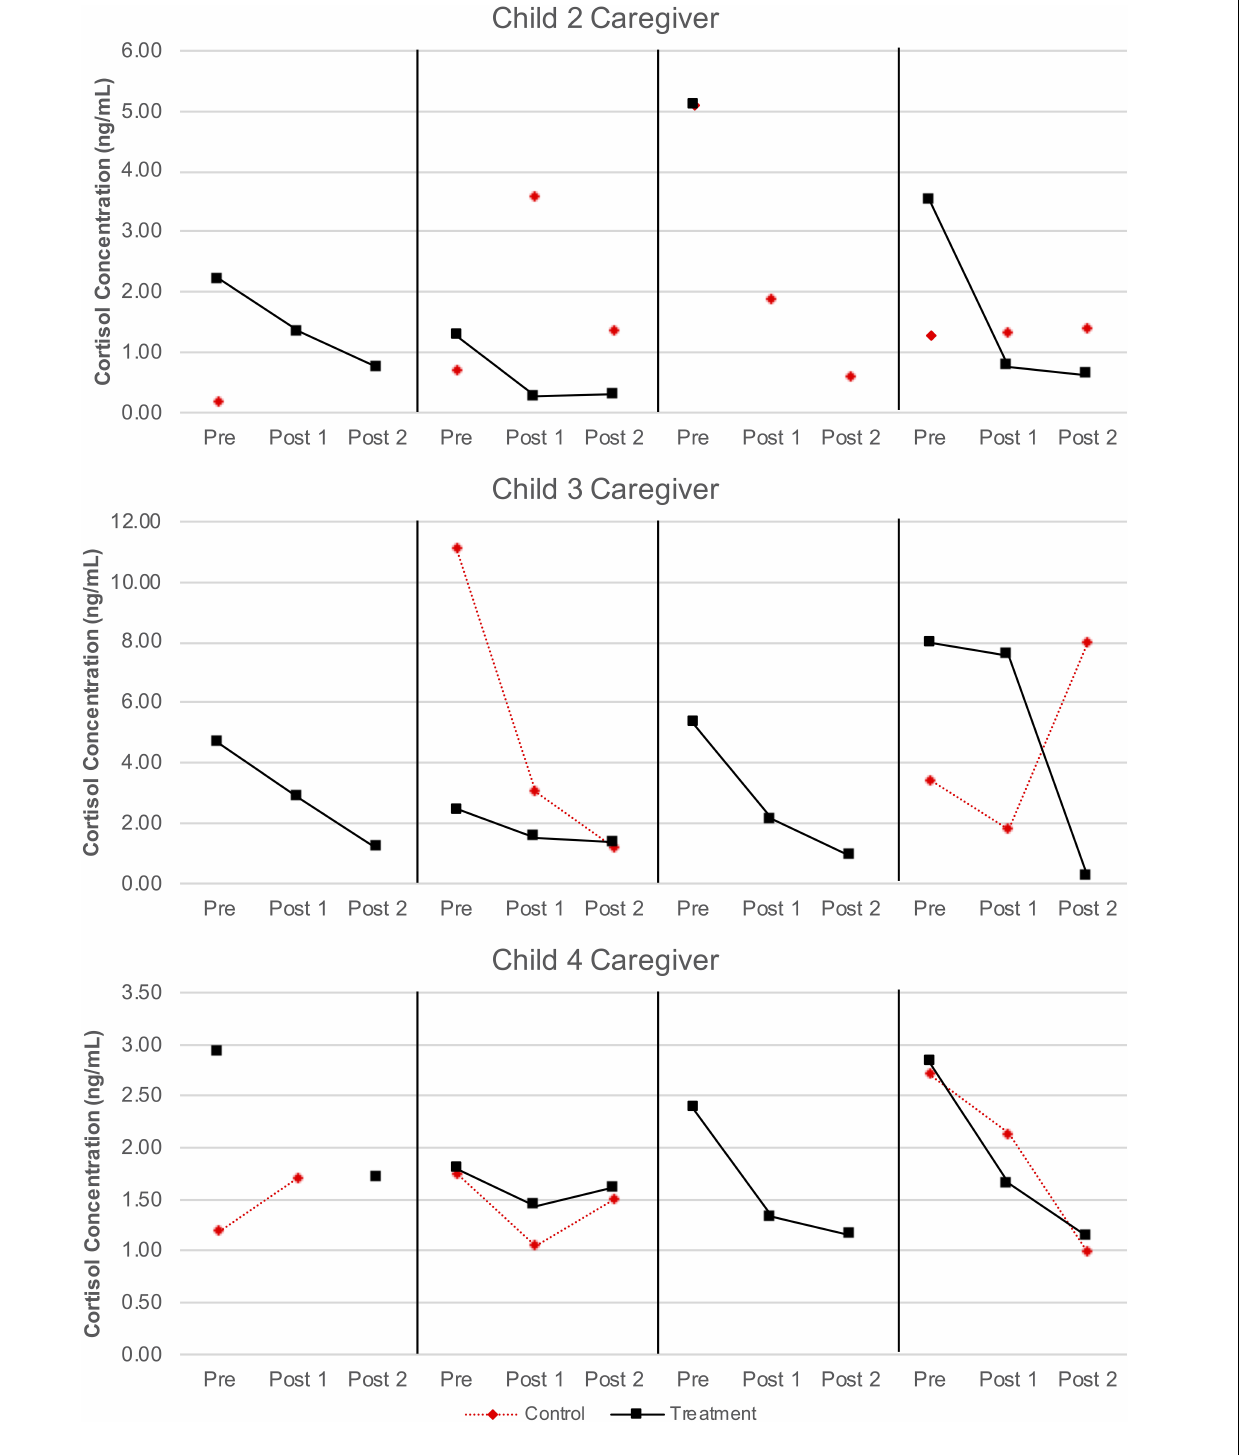
FIGURE 7 | Caregiver salivary cortisol concentrations.